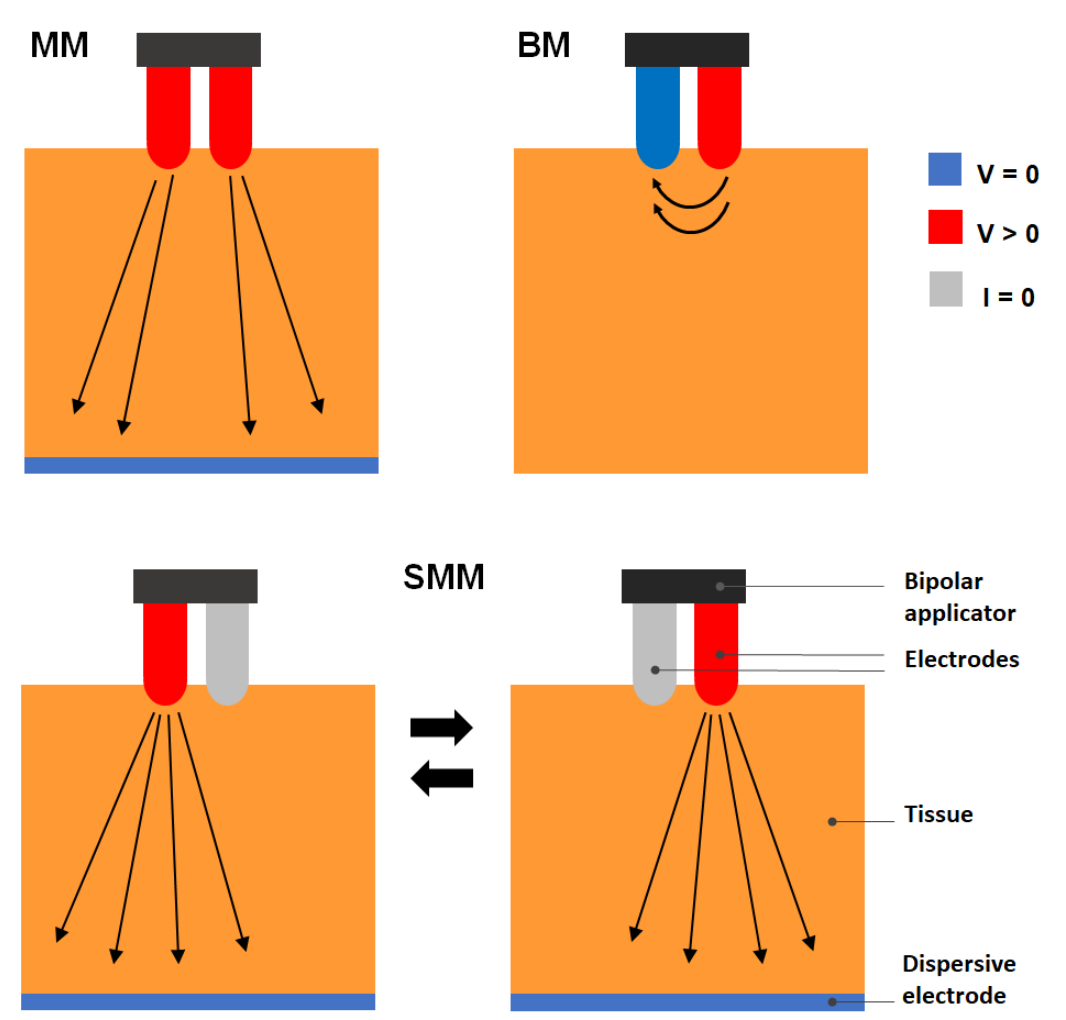
Figure 1. Scheme of the radiofrequency (RF) application modes: monopolar mode (MM), bipolar mode (BM), and switching monopolar mode (SMM). Arrows indicate the direction of the current flow.